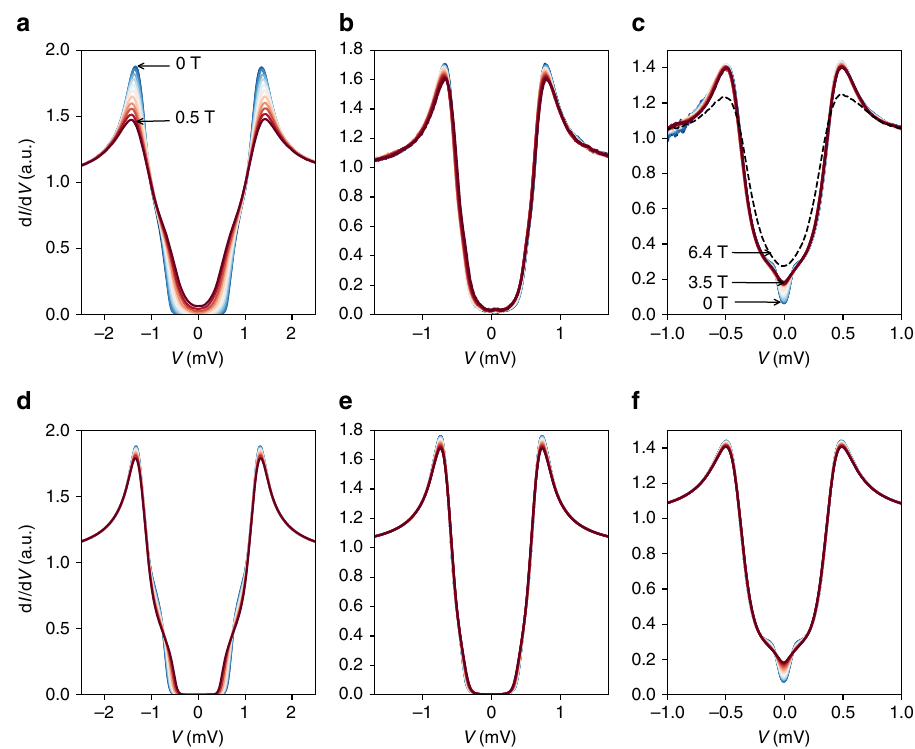
Fig. 3 Response of the tunneling conductance to parallel magnetic fi elds. a d I /d V curves at increasing magnetic fi eld parallel to the NbSe 2 layers ( H || ) of the bulk sample, at 0 < H || < 0.5 T. b Same for the 4-layer device at 0 < H || < 3.5 T, and c same for the 3-layer device. Dashed line in c : d I /d V curve taken with the 3-layer device at uncompensated parallel fi eld of 6.4 T. d – f d I /d V calculated from the KZ model for the bulk, 4-layer and 3-layer, respectively. Model parameters are given in Supplementary Note